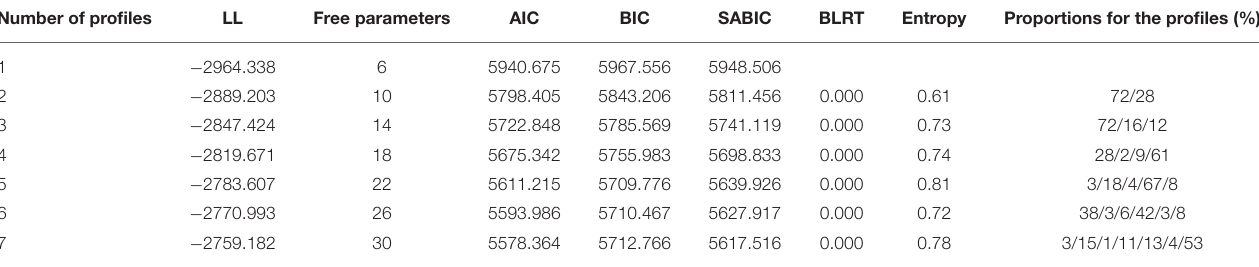
TABLE 2 | Latent profile fit statistics. Number of